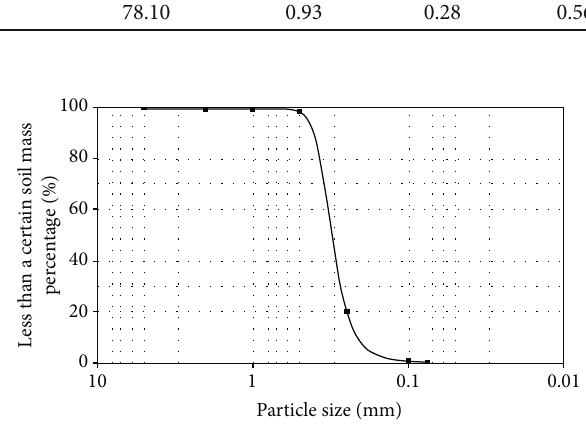
Figure 6: Grain analysis diagram of